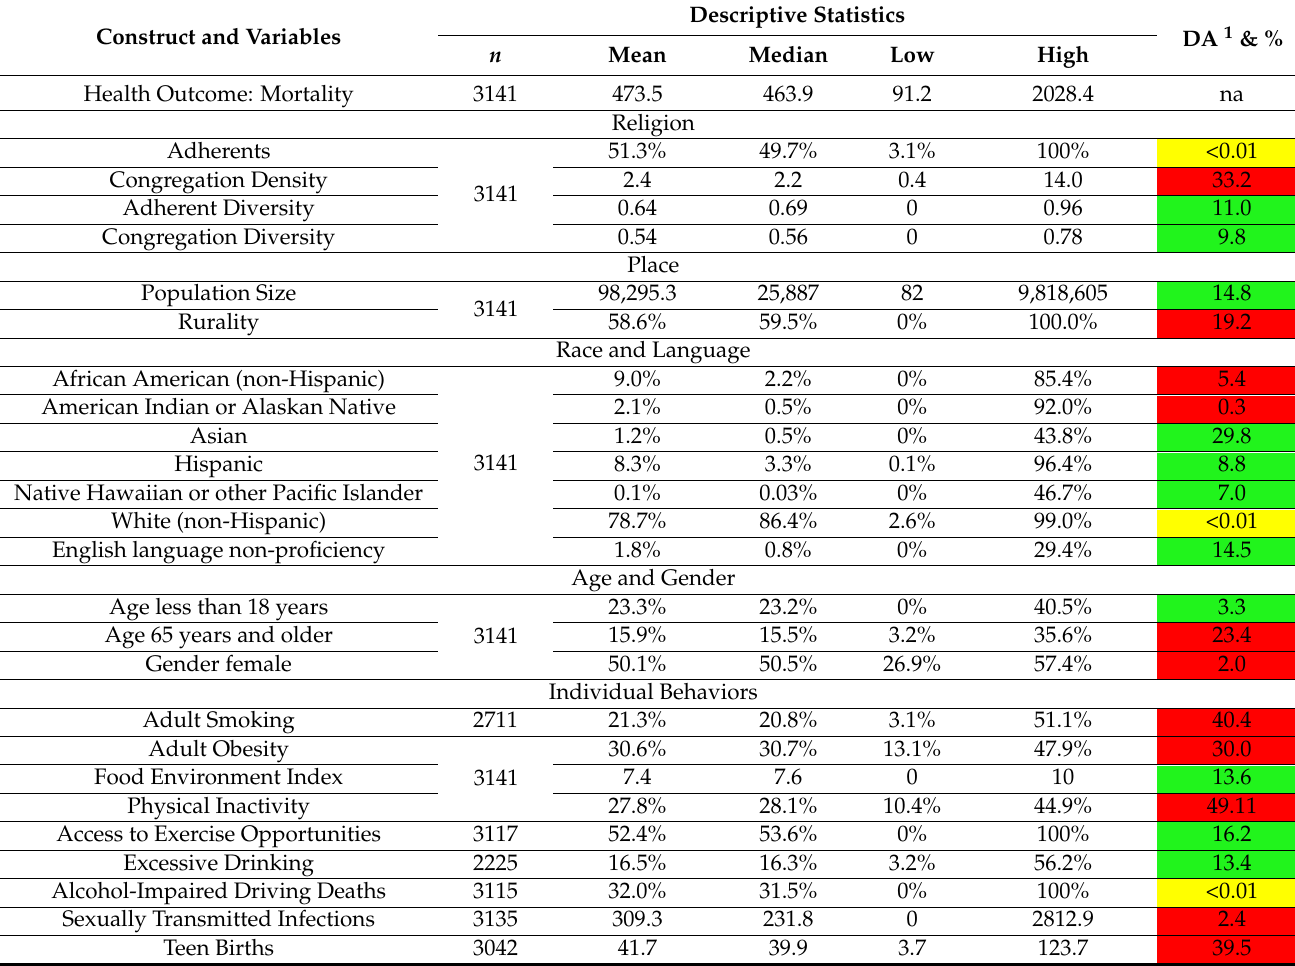
Table 1. County Descriptive Statistics, Single-Covariate Meta-Regression Direction of Association (DA) and Between-County Mortality Heterogeneity Explained